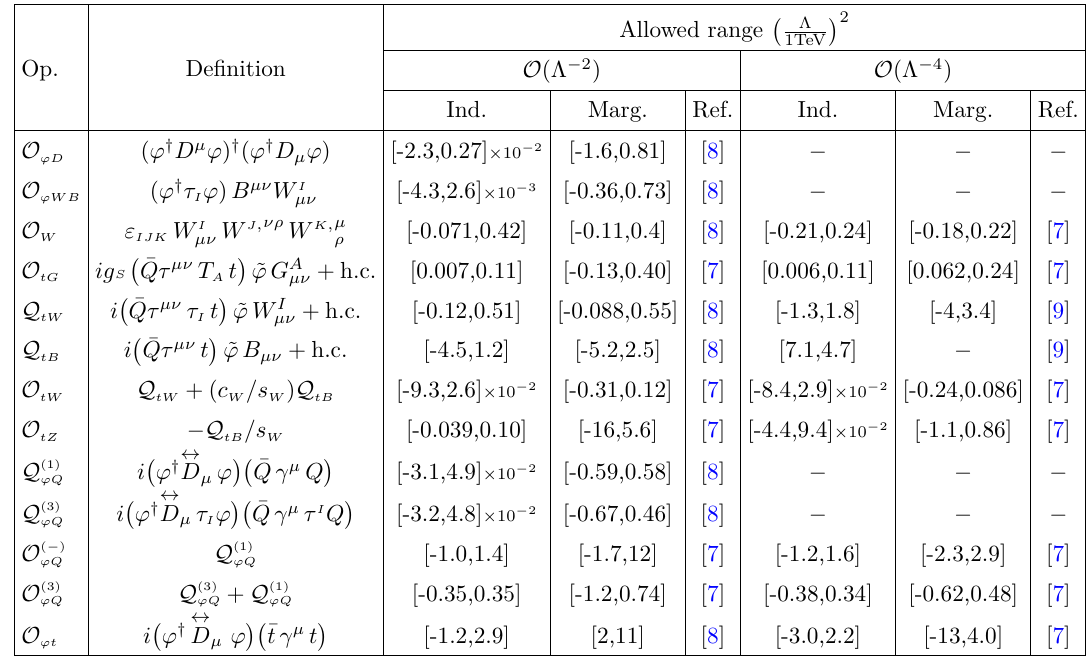
Table 1 . SMEFT operators affecting b W → t Z and/or tWZ in the U(2) 2 × U(3) 3 flavor assumption. Operators denoted by O align with the SMEFTatNLO [29] conventions used in this work, while those denoted by Q are the original Warsaw basis operators to which they are related by a simple linear rotation. Individual and marginalised limits from recent global fits are given both at linear ( O (Λ − 2 ) ) and quadratic ( O (Λ − 4 ) ) level, for Λ = 1